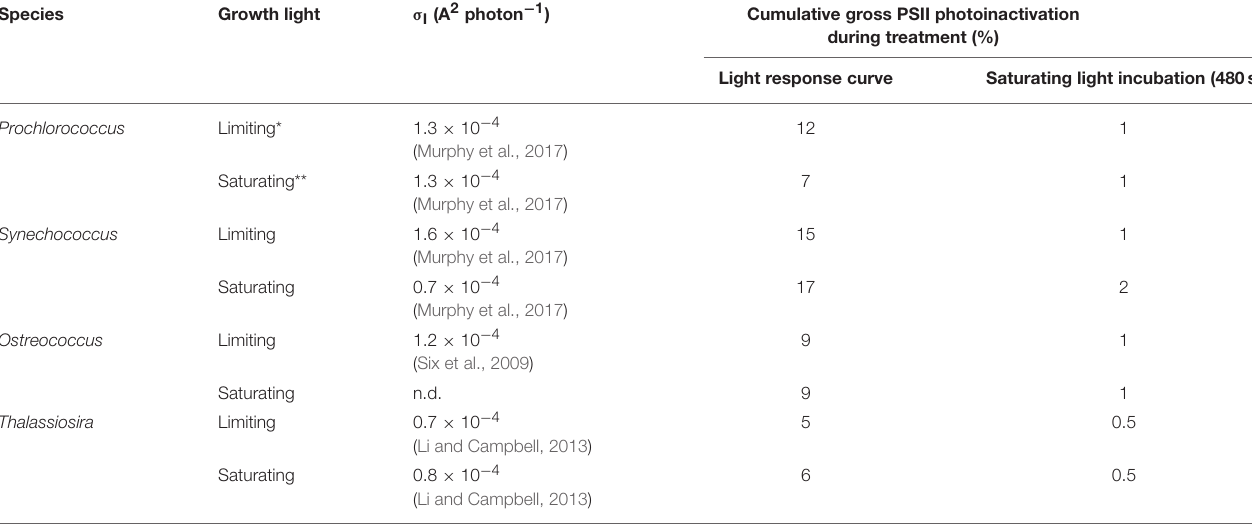
TABLE 3 | Predicted Photosystem II Photoinactivation during Light Treatments.